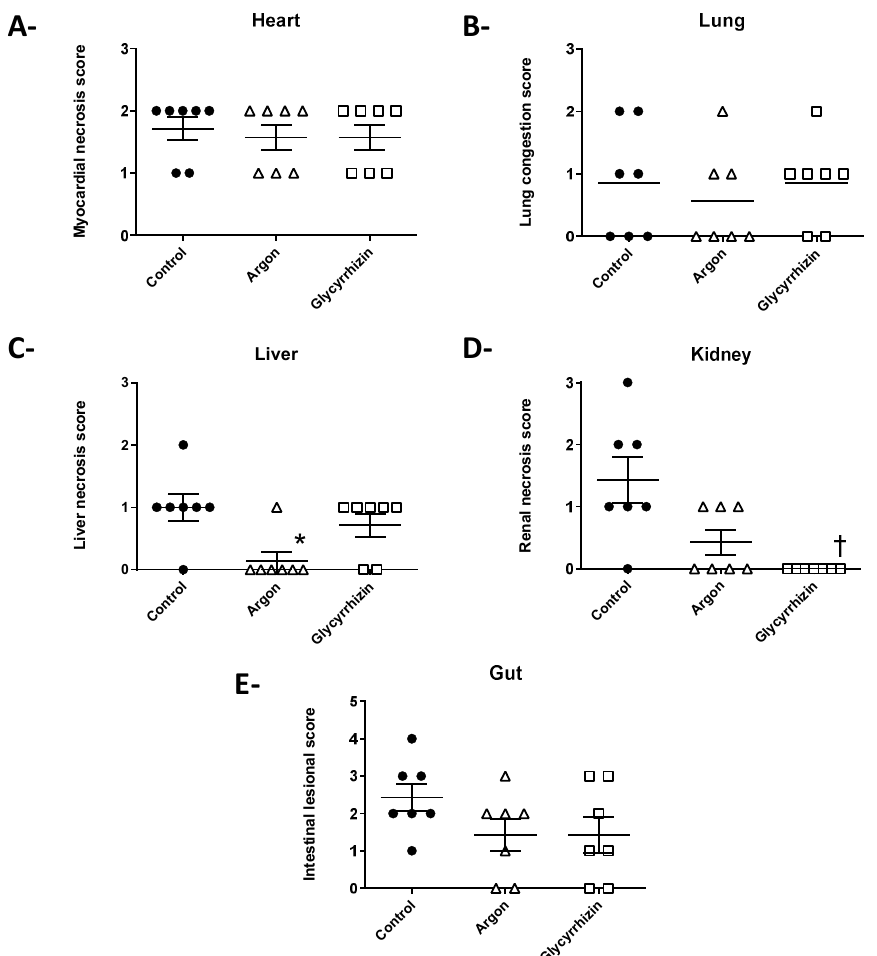
Figure 5. Histopathological score of alteration in the heart ( A ), lung ( B ), liver ( C ), kidney ( D ) and gut ( E ). * p < 0.05 between Control and Argon; † p < 0.05 between Control and Glycyrrhizin.